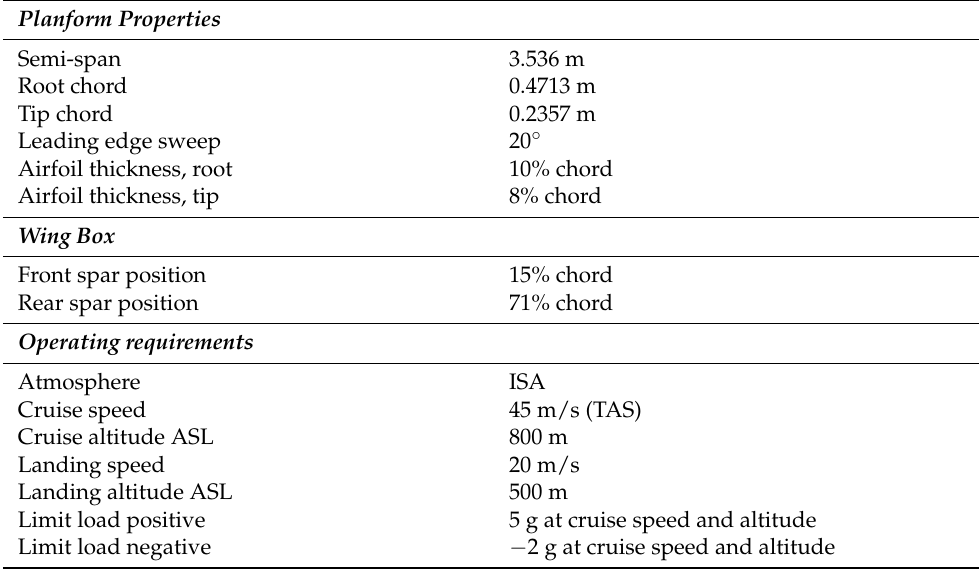
Table 1. Design specifications of the wings.